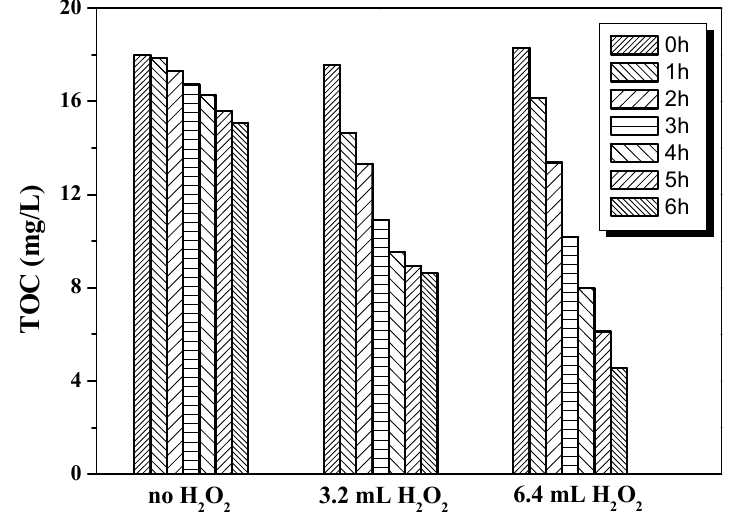
Figure 9. Photocatalytic activity test of the PRD-reactor for biodegraded wastewater.